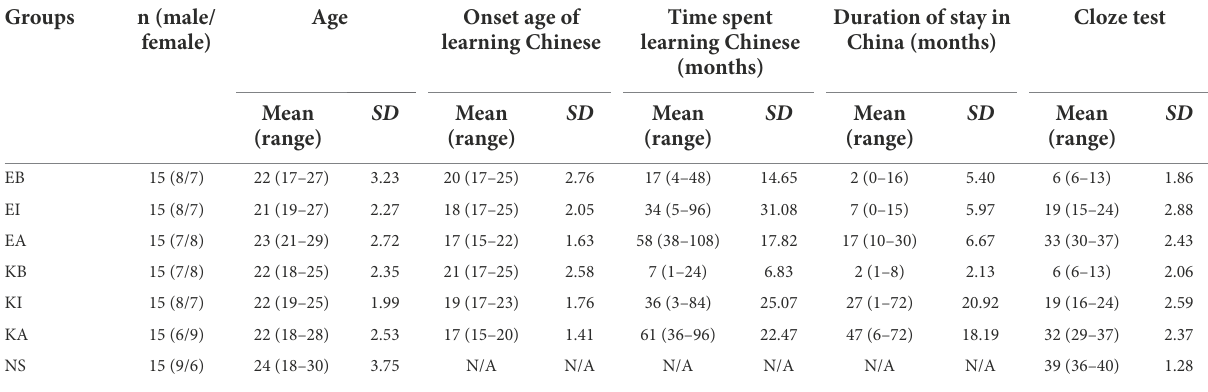
TABLE 3 Information about participants in each